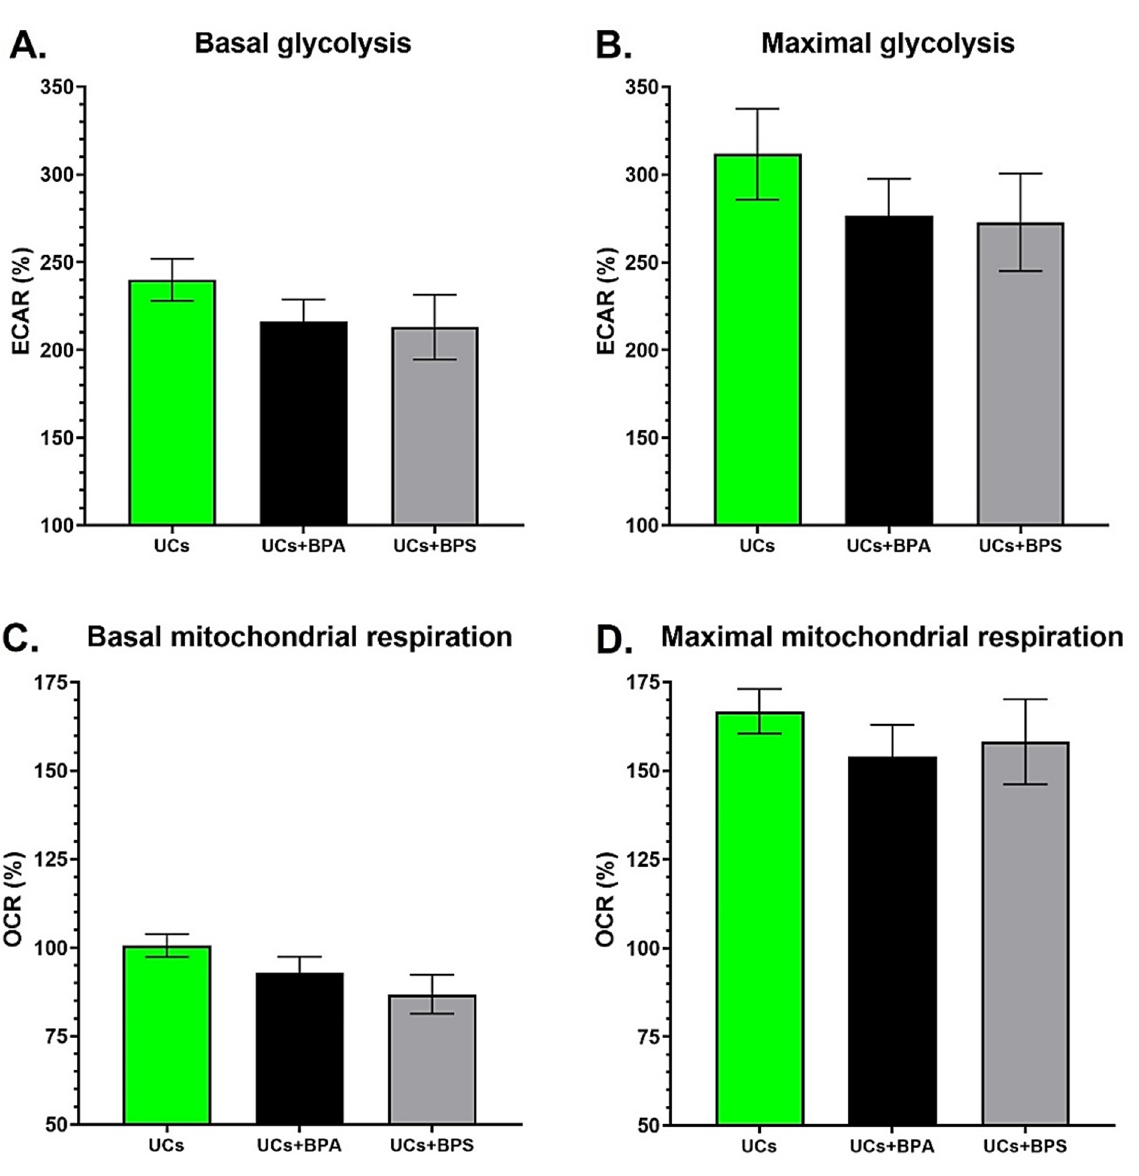
Figure 2. Chronic exposure to physiological concentrations of BPA or BPS has no significant effect on the glycolysis and mitochondrial respiration of normal urothelial cells. ( A , B ) ECAR and ( C , D ) OCR were determined using the XFe96 Extracellular Flux Analyzer for normal urothelial cells (UCs) with or without chronic exposure to physiological concentrations of BPA or BPS to establish ( A ) basal glycolysis, ( B ) maximal glycolytic capacity, ( C ) basal mitochondrial respiration and ( D ) maximal mitochondrial capacity. Analyses represent the results for two populations of normal urothelial cells (UC1 and UC2). Data are presented as the mean ± SEM and displayed as percentages of controls (i.e., untreated condition) (n ≥ 3, N = 4). A baseline (100%) was established before injections (see Figure S2). p < 0.05 by Mann–Whitney